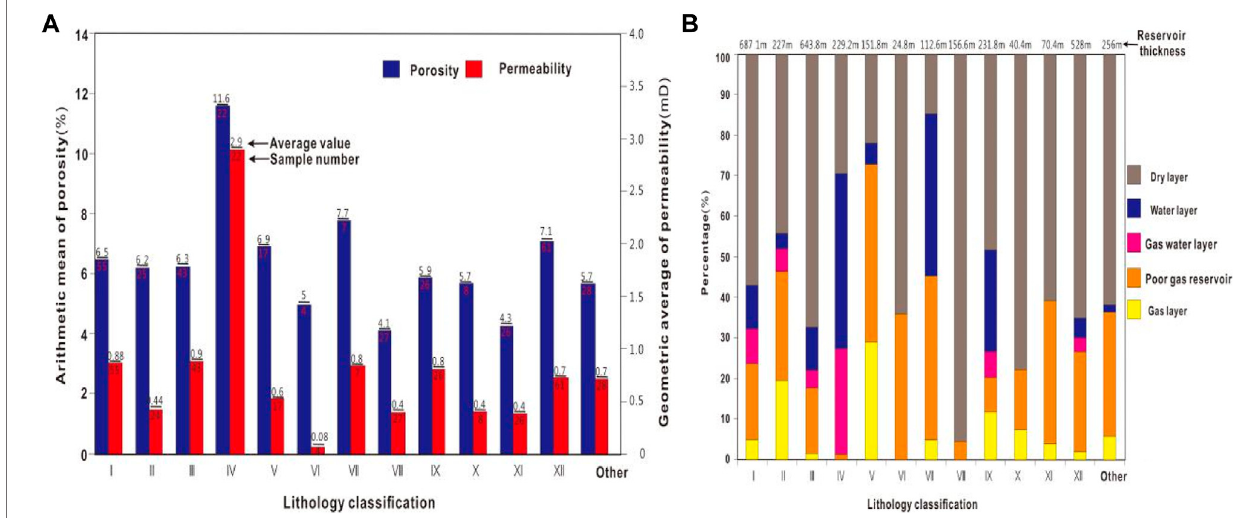
FIGURE 14 | Relationship between volcanic reservoir physical properties, effective reservoir distribution, and rock types. Notes: I — coarse andesite, II — coarse andesitic breccia lava, III — coarse andesitic volcanic breccia, IV — coarse andesitic tuff, V — rhyolite, VI — rhyolitic tuff lava, VII — trachyte, VIII — andesite, IX — andesitic volcanic breccia, X — andesitic tuff, XI — sedimentary tuff, and XII — sedimentary breccia. (A) Histogram of the lithology physical property relationship of the volcanic reservoir. (B) Histogram of the lithology effective reservoir relationship of the volcanic reservoir.